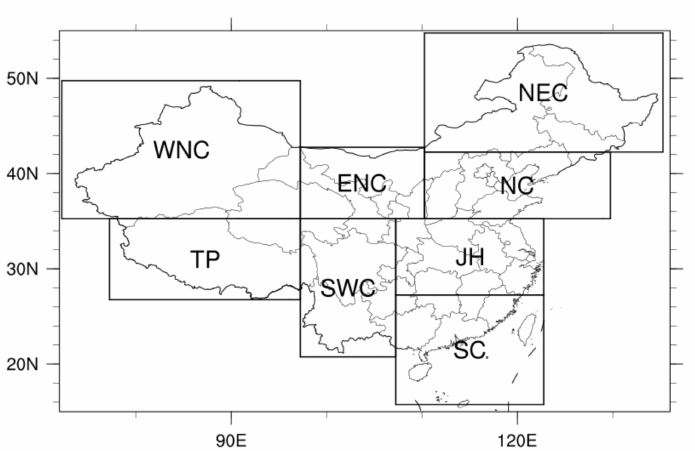
Figure 1. Eight sub-regions of China including NEC (Northeast China, 42.25 ◦ N–54.75 ◦ N, 110.25 ◦ E–135.25 ◦ E), NC (North China, 35.25 ◦ N–42.25 ◦ N, 110.25 ◦ E–129.75 ◦ E), JH (Jianghuai, 27.25 ◦ N–35.25 ◦ N, 107.25 ◦ E–122.75 ◦ E), SC (South China, 15.75 ◦ N–27.25 ◦ N, 107.25 ◦ E–122.75 ◦ E), SWC (Southwest China, 20.75 ◦ N–35.25 ◦ N, 97.25 ◦ E–107.25 ◦ E), TP (Tibetan Plateau, 26.75 ◦ N–35.25 ◦ N, 97.25 ◦ E–107.25 ◦ E), WNC (Western Northwest China, 35.25 ◦ N–49.75 ◦ N, 7.25 ◦ E–97.25 ◦ E) and ENC (Eastern Northwest China, 35.25 ◦ N–42.75 ◦ N, 97.25 ◦ E–110.25 ◦